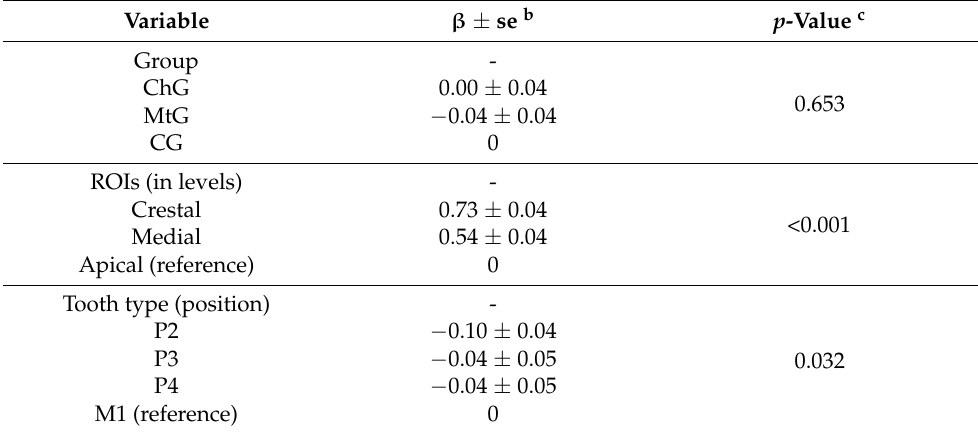
Table 2. Multiple linear regression with BD as the dependent variable, in 336 sites a